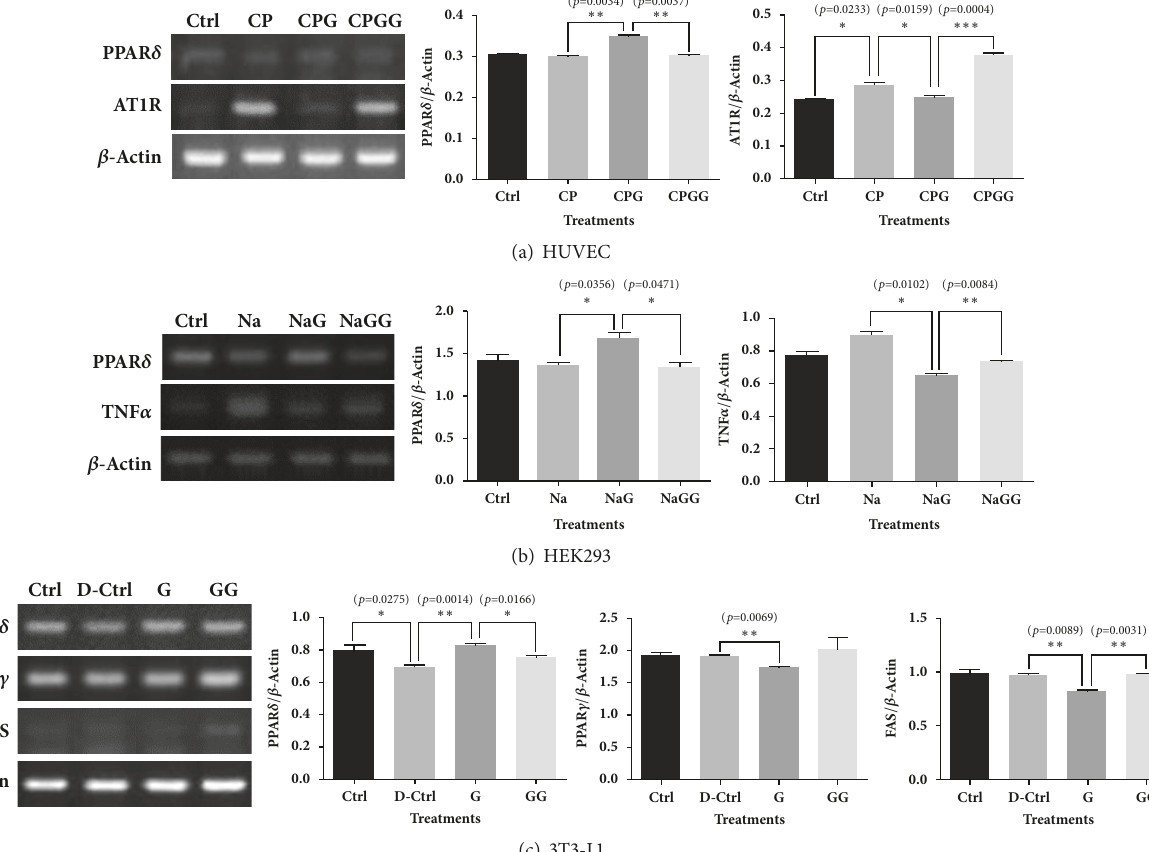
Figure 1: Th e e ff ects of 6 - g in g er o l o n mRNA b i o mar k ers relate d t o hyp ertensi o n in HUVE Cs , HEK293 cells , an d d i ff erentiate d 3 T 3 - L1 cells u n d er p at ho l og ical c o n d iti o ns. (a, b, c) 6-Gingerol increased the mRNA level of PPAR 𝛿 compared with disease controls in HUVECs, HEK293, and differentiated 3T3-L1 cells. (b) Treatment with 6-gingerol decreased the mRNA level of AT1R elevated by cholesterol and palmitate treatment in HUVECs and downregulated the TNF 𝛼 mRNA levels elevated by NaCl treatment in HEK293 cells. (c) In differentiated 3T3-L1 cells, 6- gingerol decreased the levels of PPAR 𝛾 and FAS. All effects of 6-gingerol in the three cell types were offset by the PPAR 𝛿 antagonist, GSK0660. The results are expressed as means ± SEM. Values were statistically analyzed using unpaired t -tests. All experiments were repeated three or more times. The statistical significance between the two experimental groups was marked as ∗ p < 0.05, ∗∗ p < 0.01, and ∗ ∗ ∗ p < 0.001. Meaning of indications: Ctrl is an untreated control group, CP indicates a cholesterol and palmitate-treated group, CPG indicates a cholesterol, palmitate, and 6-gingerol treated group, and CPGG indicates a cholesterol, palmitate, 6-gingerol, and GSK0660 treated group; Na indicates an NaCl treated group, NaG indicates an NaCl and 6-gingerol treated group, and NaGG indicates an NaCl, 6-gingerol, and GSK0660 treated group; D-Ctrl indicates a differentiation control group without treatment, G indicates a 6-gingerol treated group during differentiation, and GG indicates a 6-gingerol and GSK0660 treated group during